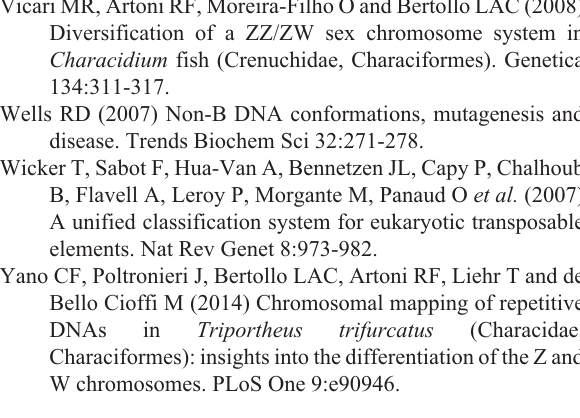
Table S1 - PCR reaction mixture for the synthesis of probes used in this work. Table S2 - Partial sequences isolated from the